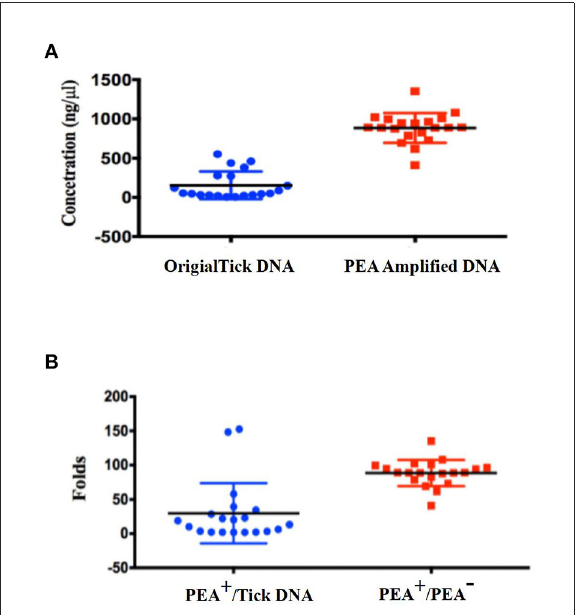
FIGURE3 DNA concentrations and PEA amplification index for singular ticks. (A) Concentration distribution of original tick DNA and PEA amplified DNA; (B) PEA amplification index for single